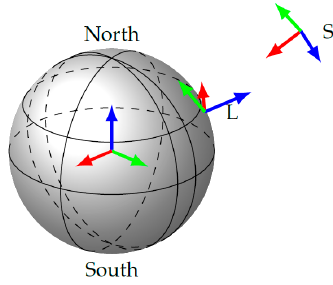
Figure 2. The relevant navigation frames for the fusion of GNSS and IMU . The figure shows the fixed frames ( ECEF and L ) and the free moving sensor frame S